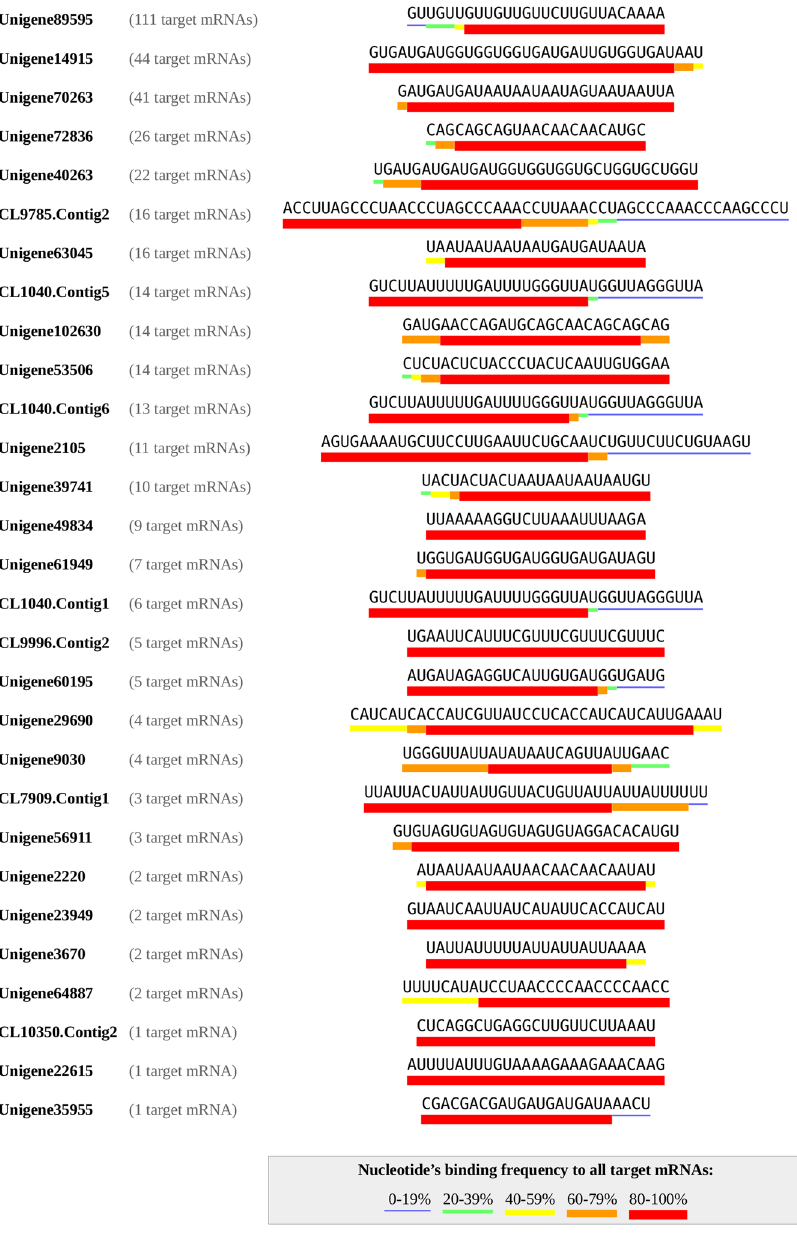
Figure 4. Inter-species conserved region of 29 lncRNAs from Palythoa caribaeorum , involved in the predicted lncRNA-mRNA interactions. Different color bars below the conserved region sequence show each nucleotide’s frequency of binding to all target mRNAs, blue: 0–19%, green: 20–39%, yellow: 40–59%, orange: 60–79%, red: